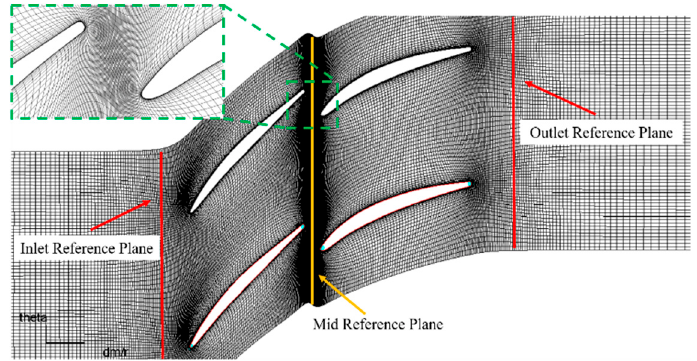
Figure 5. 2D Tandem blade model computation fluid dynamic (CFD) mesh.